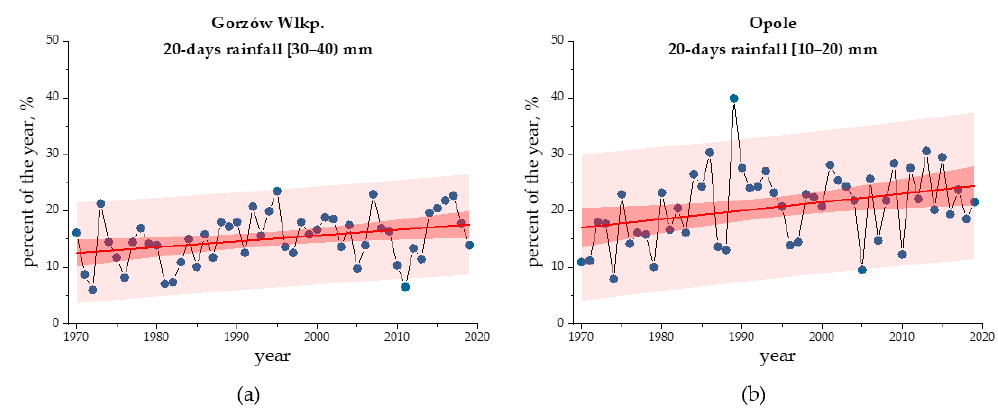
Figure 8. Statistically significant trends in the sum of twenty-day precipitation in the years 1970–2019 in ( a ) Gorzów Wielkopolski ([30–40) mm) and ( b ) Opole ([10–20) mm).